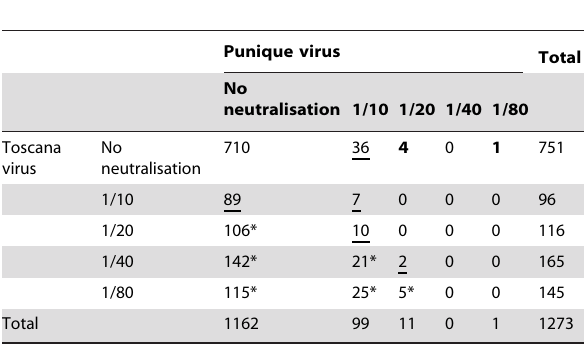
Table 2. Detailed results of microneutralisation assays against TOSV and PUNV.